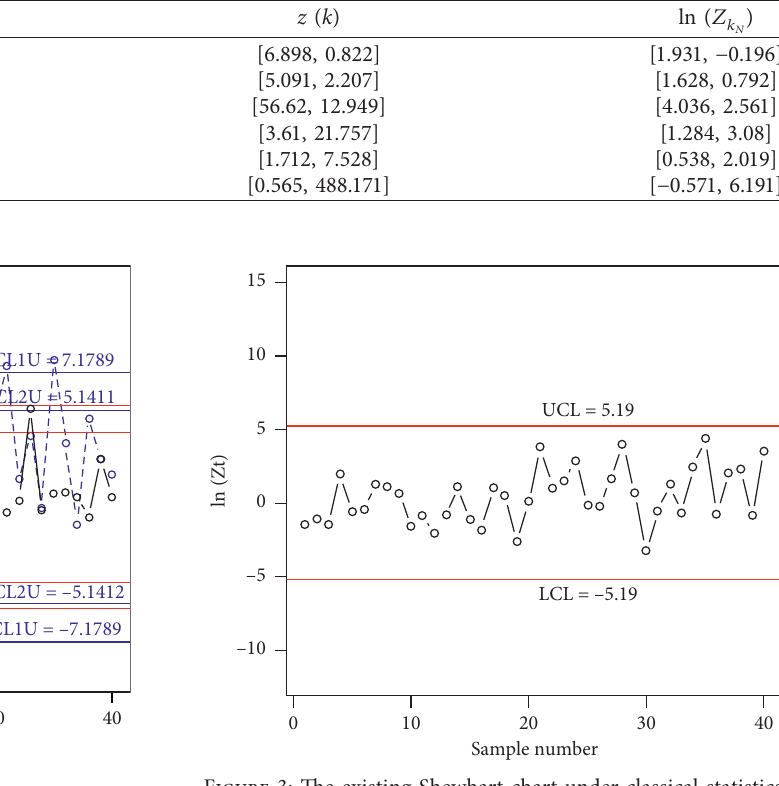
Figure 3: The existing Shewhart chart under classical statistics.